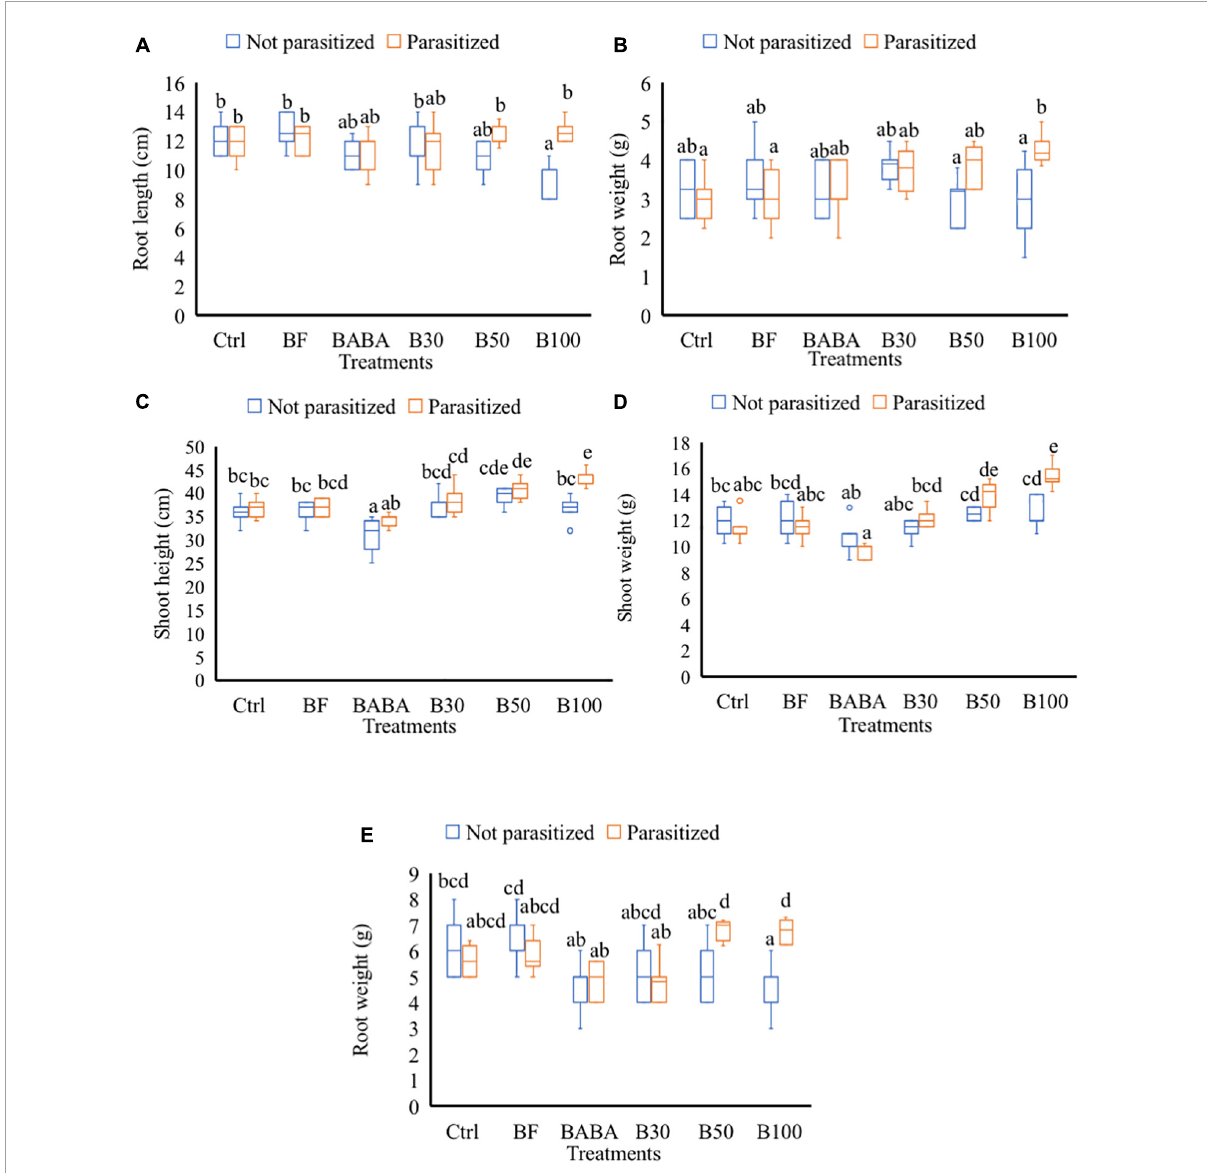
FIGURE3 Effect of P. polymyxa strain LMG27872 on tomato growth. A subset of plants (8) from each treatment were inoculated with c. 300 second-stage juveniles of M. incognita (parasitized groups) and a subset of plants were mock-inoculated (not parasitized groups). Data show the effect on plant growth, (A) root length, and (B) fresh root weight at 2 days post-inoculation (dpi) corresponding to 9 days posttreatment (dpt), (C) SH, (D) fresh shoot weight, and (E) fresh root weight at 42 dpi/49 dpt, respectively. Data were analyzed by one-way ANOVA, followed by Tukey’s post-hoc test, and data are shown by box plots with median, upper quartile, and lower quartile. Different letters indicate statistically different means at 95%